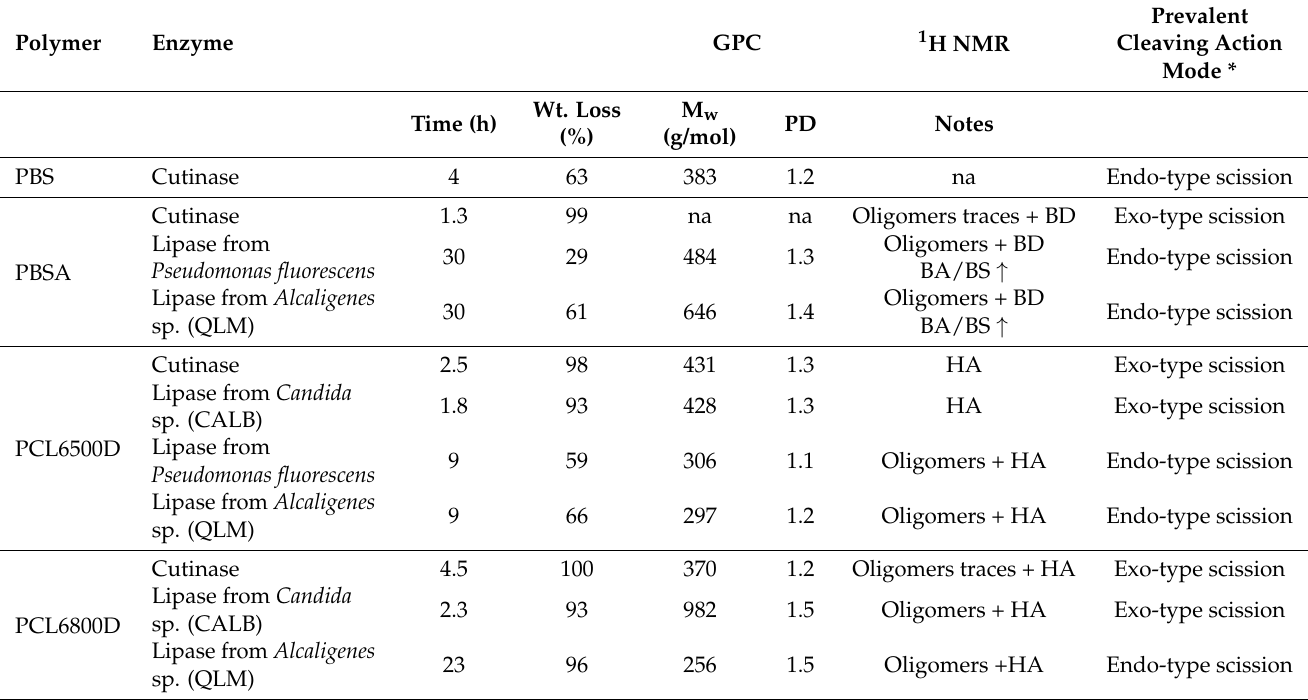
Table 6. 1 H NMR and GPC of the products extracted from the last liquid fraction of PBS, PBSA, PCL6500D and PCL 6800D films after treatment with different enzymes (BA/BS ↑ indicates that the adipate content increases respect to the succinate